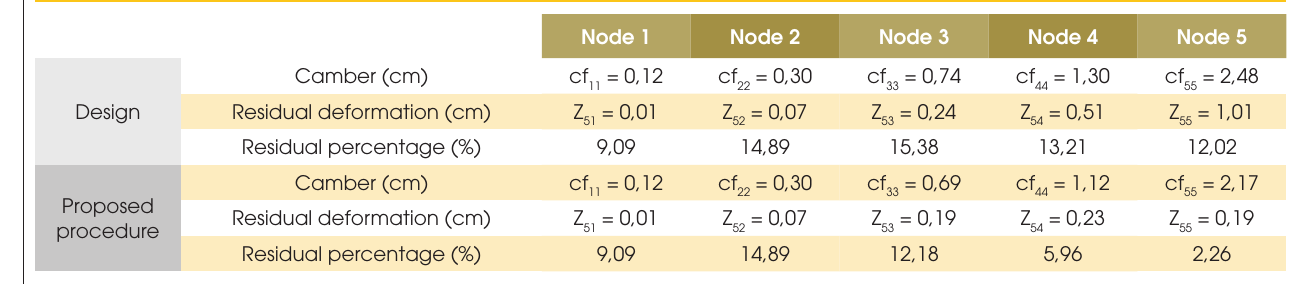
Table 6 – Camber, residual deformation and residual percentage to Case